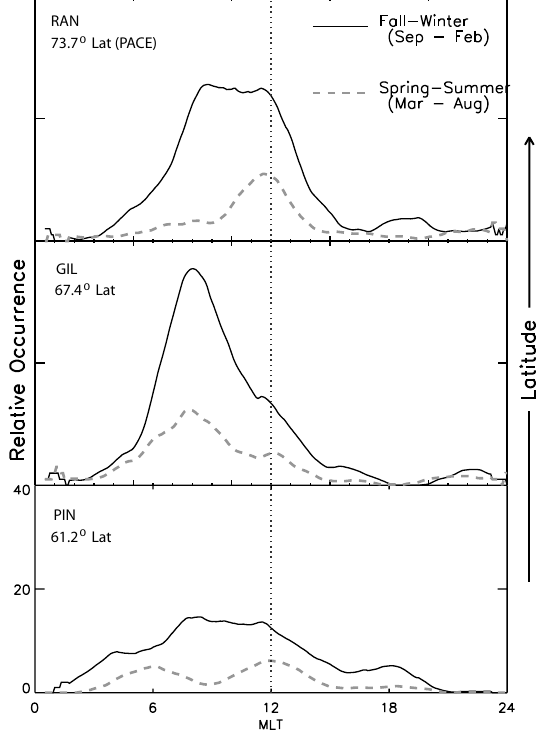
Fig. 3. Number of 5-min intervals containing Pc5 riometer